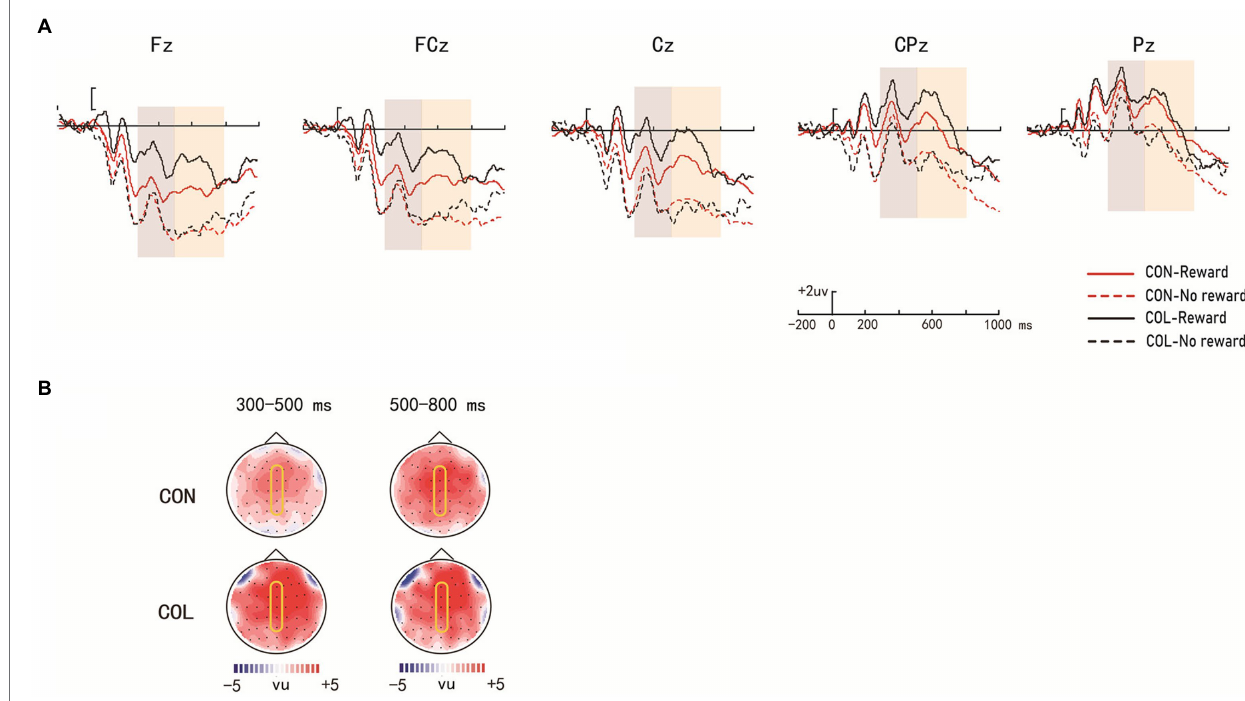
FIGURE 5 | Amplitude distribution and topographic maps of ERP measurements of reward effects for rearranged items during retrieval. (A) Amplitude distribution of ERP measurements in relation to reward effects and encoding task effects. (B) Topographic maps of ERPs on reward effects in the items encoded through the two encoding